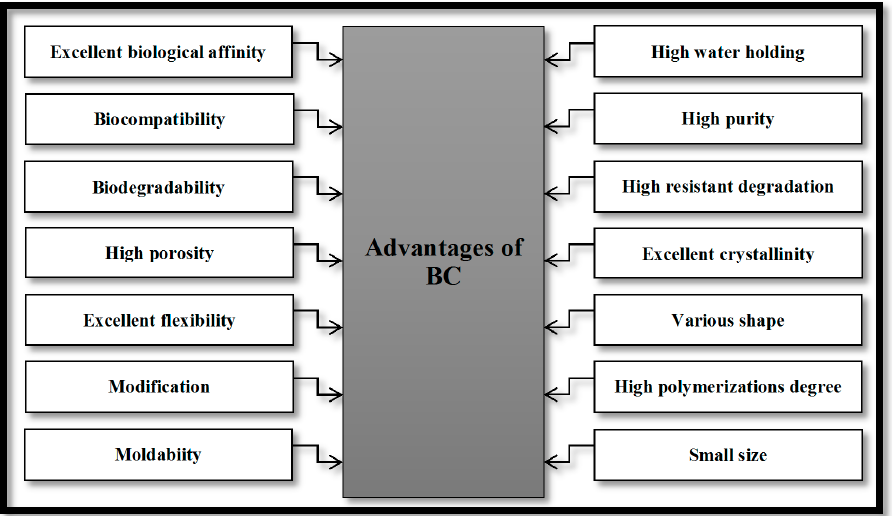
Figure 1. Advantages of bacterial cellulose.